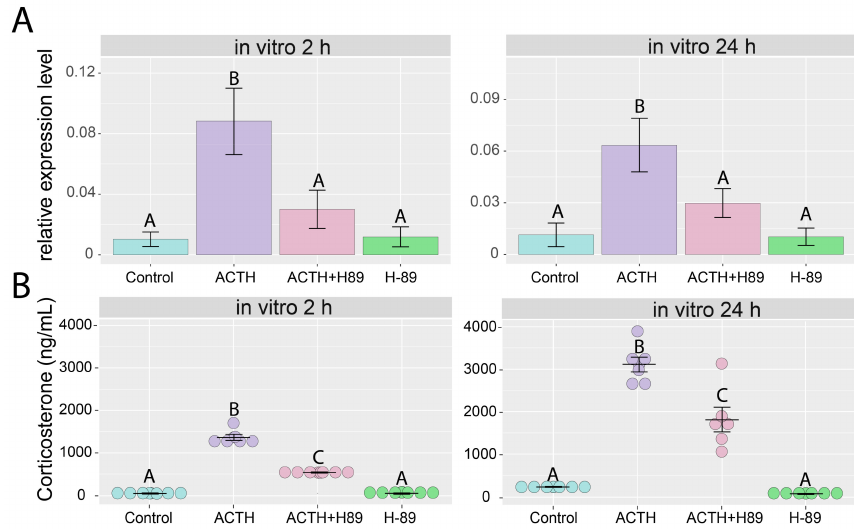
Figure 7. Effect of protein kinase A inhibitor—H-89 (10 − 5 M) on basal and ACTH (10 − 7 M) stimulated Giot1 gene expression in primary culture of rat adrenocortical cells. ( A ) The expression of Giot1 was determined by qPCR method. Cells were collected for RNA isolation 2 and 24 h following administration of the tested compounds. Bars represent means ± SEM ( n = 5); ( B ) effect of H-89 (10 − 5 M) on basal and ACTH (10 − 7 M) stimulated corticosterone output in primary cultures of rat adrenocortical cells. Cell culture media were collected at 2 and 24 h after administration of the tested compounds. Corticosterone concentration was determined by ELISA. Data are presented as means ± SEM ( n = 6). Statistical analysis of the data was performed by using one-way analysis of variance (ANOVA) followed by Tukey’s HSD test. Groups sharing the same letter are not significantly different according to Tukey’s HSD test.